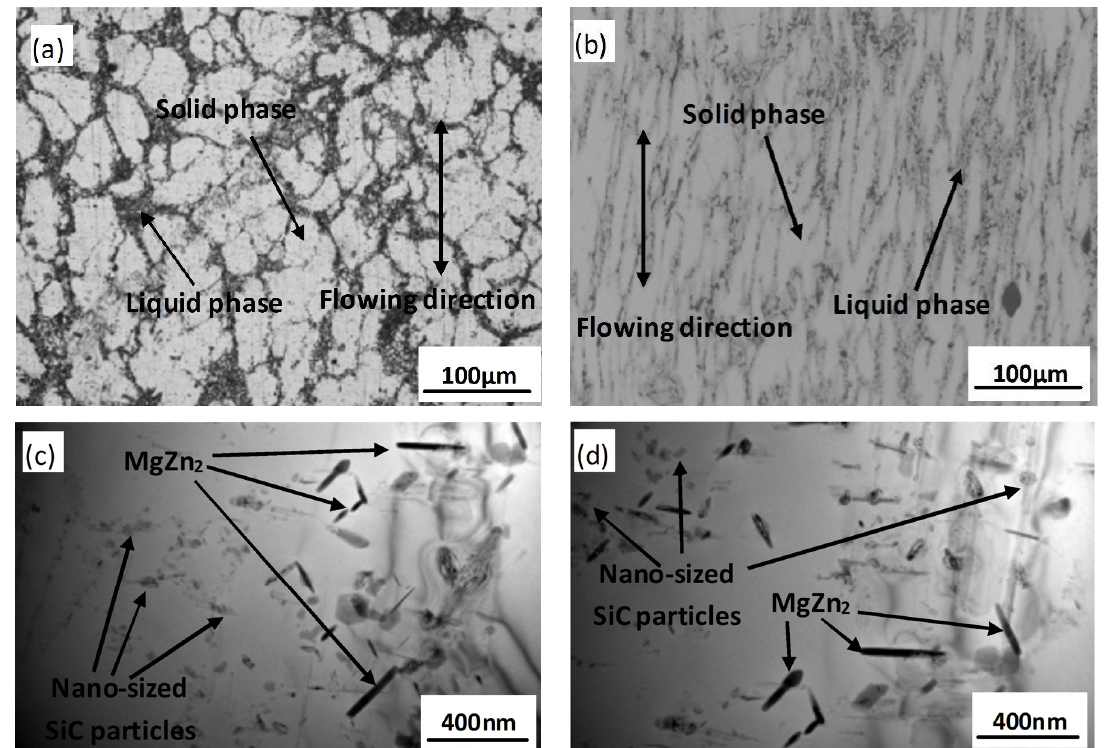
Figure 1. Micrographs of the rheoformed and thixoformed nanocomposite parts. ( a ) metallograph of the rheoformed at a stirring temperature of 620 °C ( b ) metallograph of the thixoformed at a remelting temperature of 590 °C. ( c ) TEM image of the rheoformed part ( d ) TEM image of the thixoformed part. Table 1. Experimental procedures of dry sliding wear tests of nano ‐ sized SiCp/7075 composite parts fabricated by rheoforming and thixoforming.